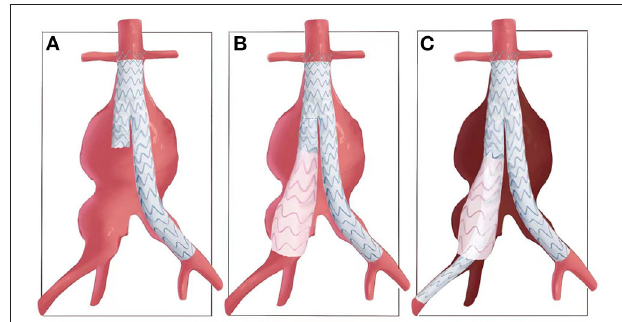
FIGURE 1 | Illustration of common-iliac-artery skirt technology. (A) An aorto-iliac artery aneurysm and release of the bifurcated main body graft. (B) Then, a flared iliac limb is deployed at aneurysmal CIA and with its distal end locating at and sealing the iliac bifurcation, which is named as skirt-limb. (C) Another iliac limb with the same proximal diameter of skirt limb is deployed overlap with skirt-limb and elongated to EIA, with IIA excluded and possible reflux of IIA was restricted between the two iliac limbs.